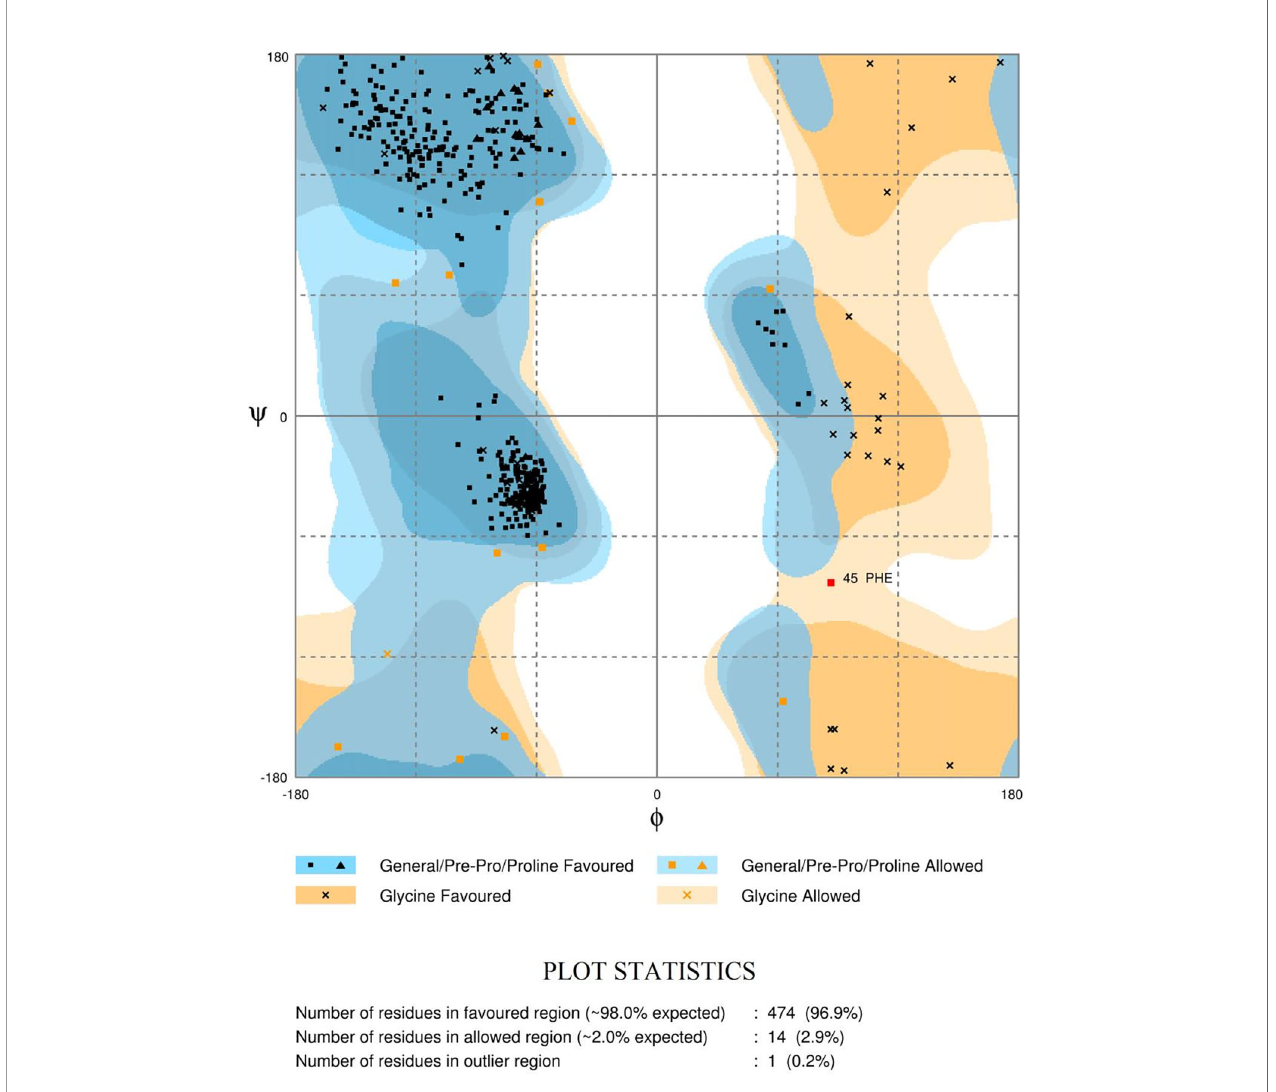
FIGURE 4 | Ramachandran plot of the Ld TR modeled receptor obtained via RAMPAGE. The plots evaluate the residues in the outlier, allowed and favoured regions.